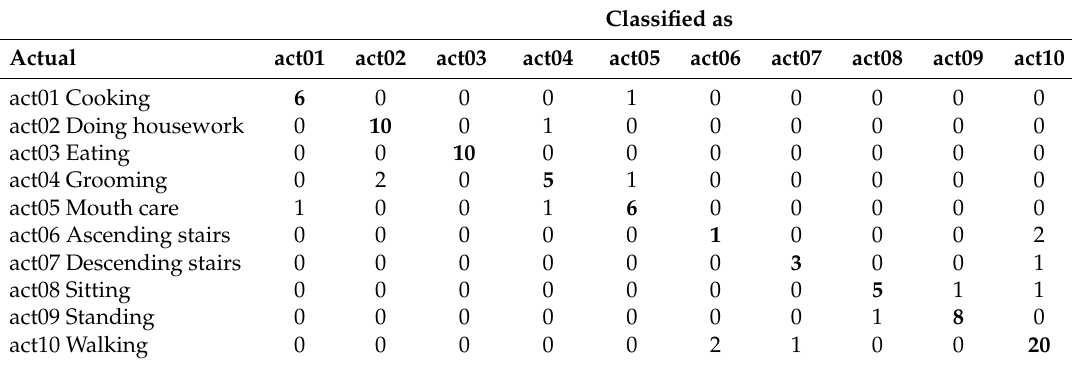
Table 5. Confusion matrix of classification results of Table 4 using Naive Bayes algorithm.